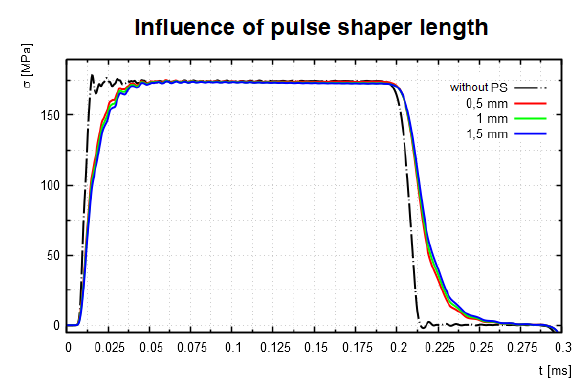
Figure 10. Influence of the length of the PS